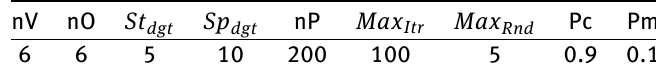
Table 35: VSSCGA Settings for Neurophysiology Application (case 2) nV